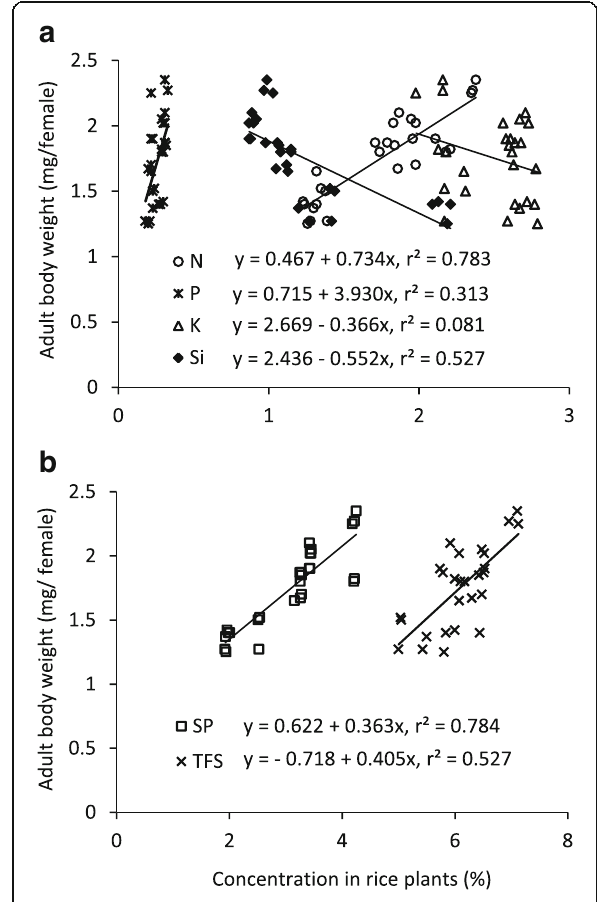
Fig. 5 Relationship of Nilaparvata lugens adult body weight with plant tissue nutrient concentration. a nitrogen (N), phosphorus (P), potassium (K), and silicon (Si), b soluble protein (SP), and total free sugar (TFS) content in rice plant ( n =